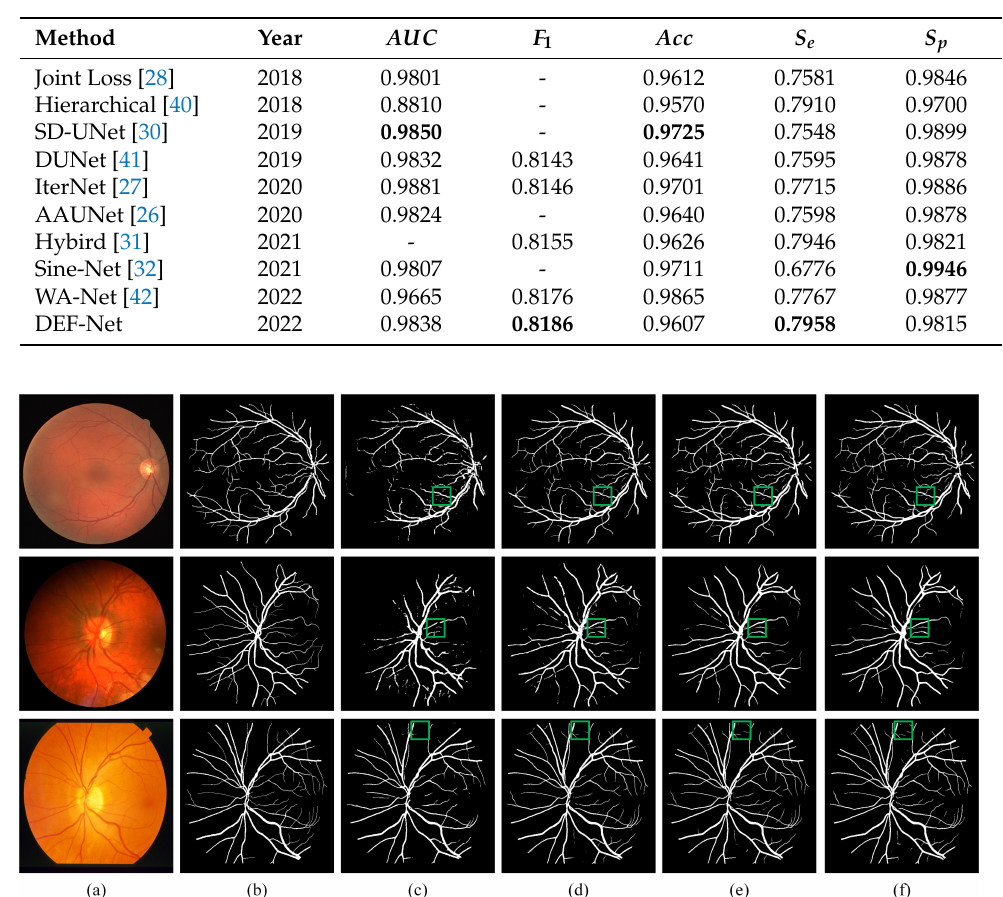
Figure 6. Visual examples of qualitative results. ( a ) Fundus images; ( b ) Ground truth of fundus images; ( c ) Results of R2U-Net; ( d ) Results of U-Net; ( e ) Results of Attention-UNet; ( f ) Results of proposed